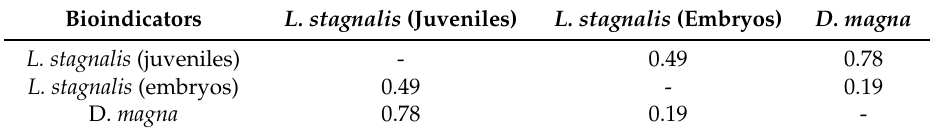
Table 9. Results of Tukey’s HSD test for significance of differences between the organisms